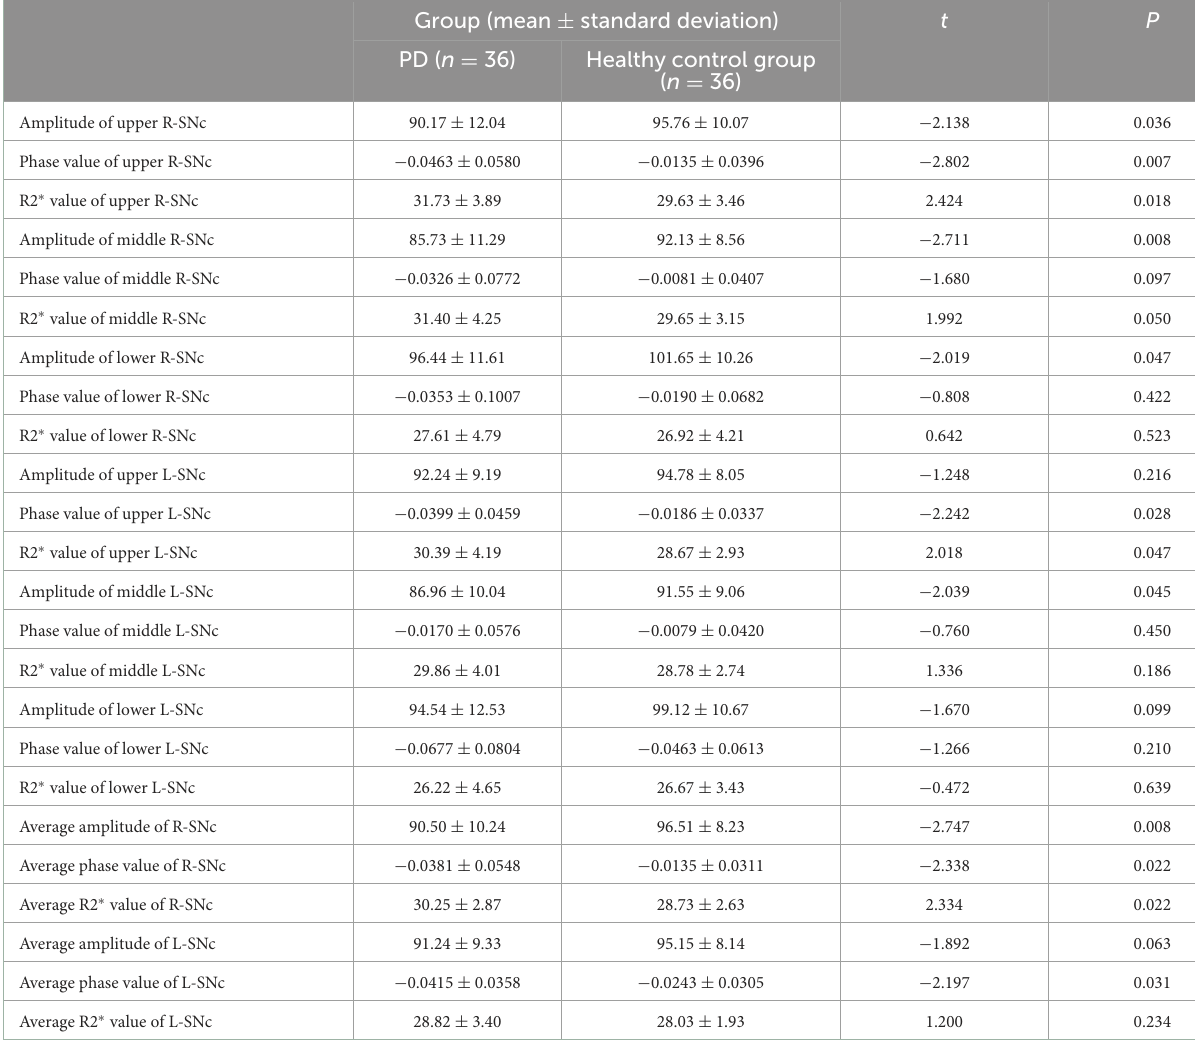
TABLE 2 Based on the comparison between the upper, middle and lower three sub regions and the average iron deposition groups of